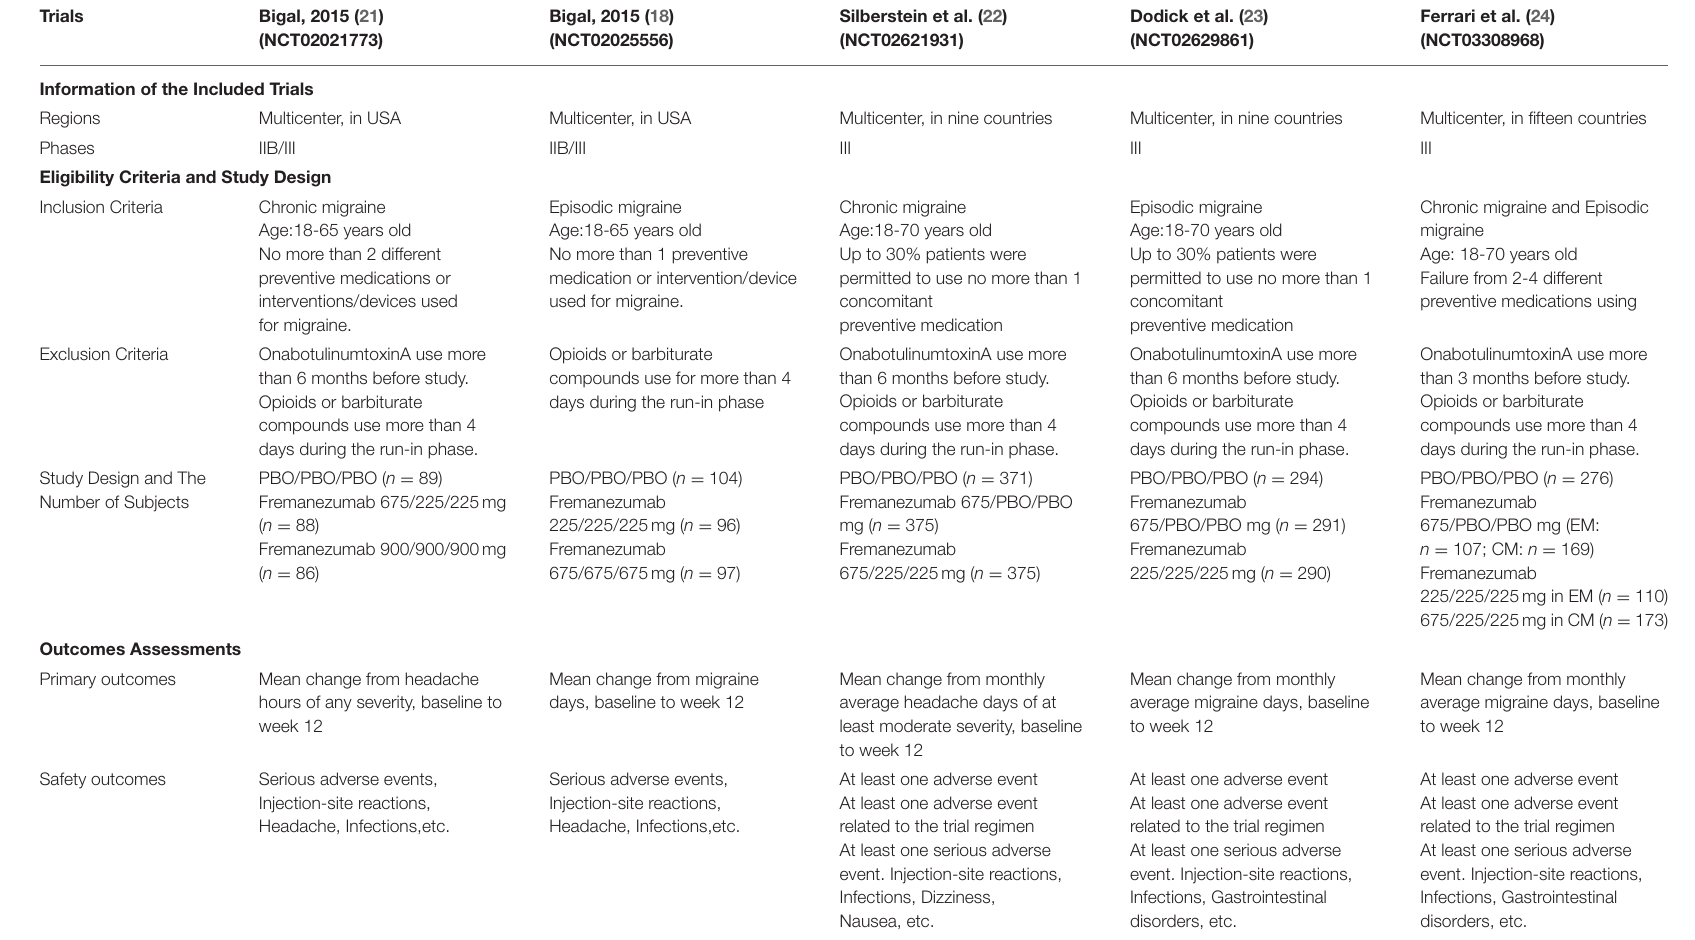
TABLE 1 | Characteristics of the included studies and outcome